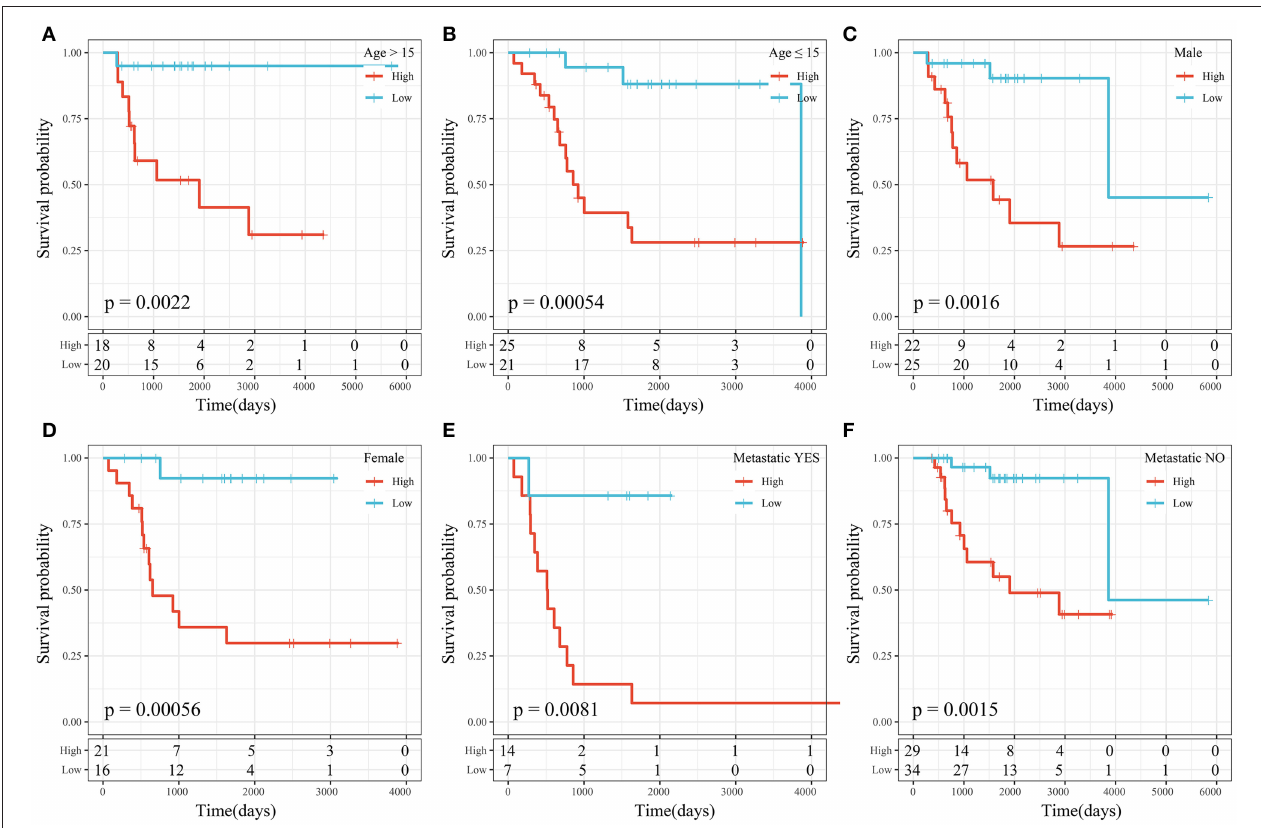
FIGURE 10 | (A) KM curve of high- and low-risk samples with age > 15 years. (B) KM curve of high- and low-risk samples with age ≤ 15 years. (C) KM curve of high- and low-risk samples of male sex. (D) KM curve of high- and low-risk samples of female sex. (E) KM curve of high- and low-risk samples with metastasis. (F) KM curve of high- and low-risk samples without